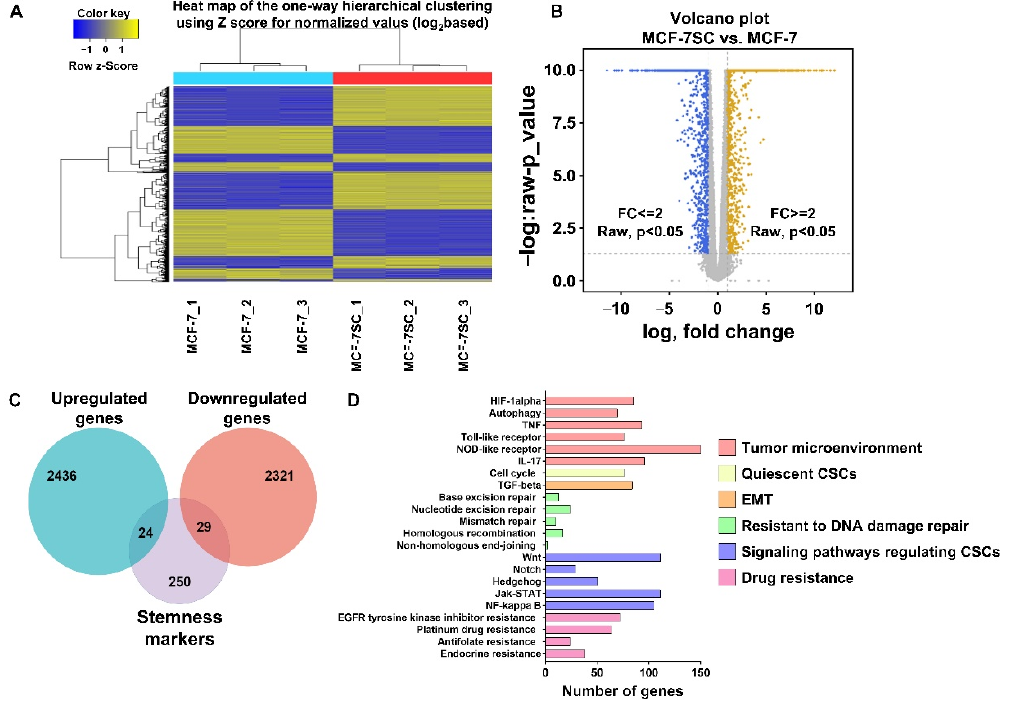
Figure 2. Transcriptome analysis of cultured MCF-7SCs. ( A ) Heat map of one-way hierarchical clustering using Z-score for normalized value (log2-based). ( B ) Volcano plot comparison of MCF-7 cells (fold change (FC) ≤ 2, p < 0.05) and MCF-7SCs (FC ≥ 2, p < 0.05). ( C ) Venn diagram showing the number of overlapped genes between upregulated and downregulated genes with stemness markers from a published database. ( D ) Representative stemness-related signaling pathways in MCF-7SCs compared with MCF-7 cells.